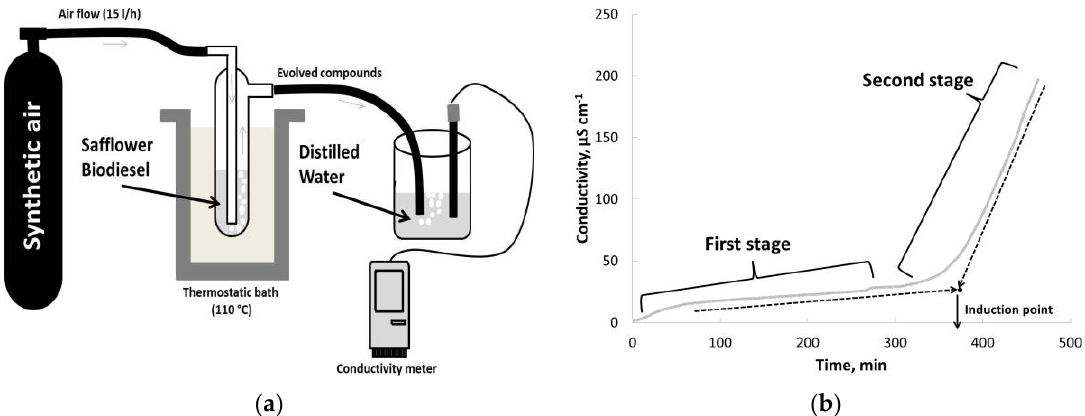
Figure 2. ( a ) Rancimat method and ( b ) induction point determination (example at 380 min).